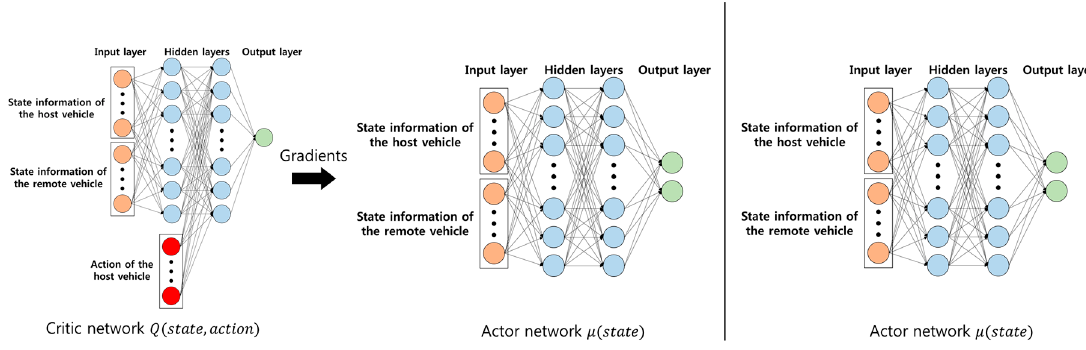
Figure 2. Neural networks in training and testing phase.